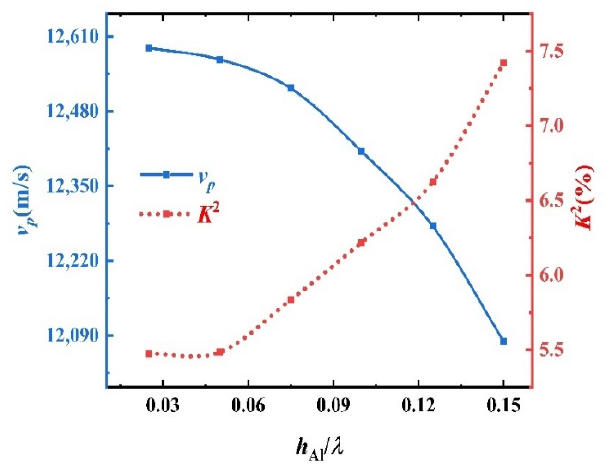
Figure 10. Curves of v p and K 2 against h AlN / λ in M2 mode.